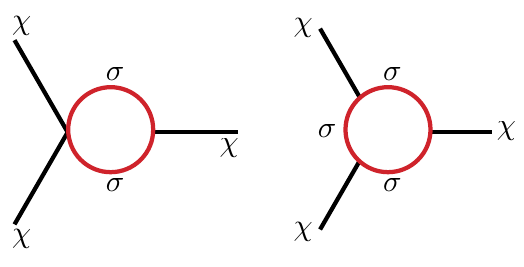
Figure 1 . The diagrams that contributes to h (cid:14)(cid:31)(cid:14)(cid:31)(cid:14)(cid:31) i